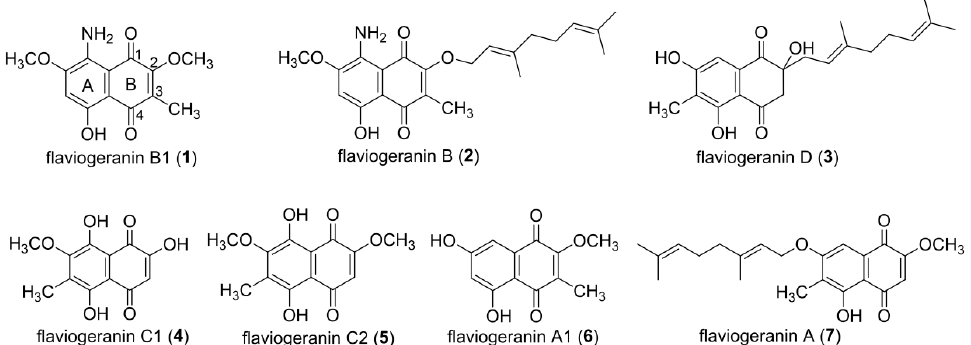
Figure 2. Structures of flaviogeranin congeners isolated from Streptomyces sp. 1–3 are new compounds and 4 – 7 are known